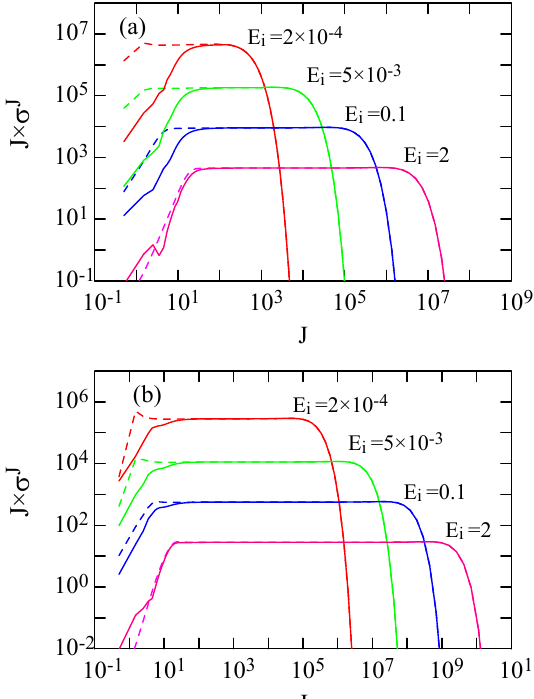
Figure 3. Variation of J × σ J with partial waves J for ( a ) 3s 1/2 –3p 3/2 and ( b ) 3d 3/2 –3p 3/2 transitions. Broken curves: Born and continuous curves: CC+Born results. Energies are in Ryd.